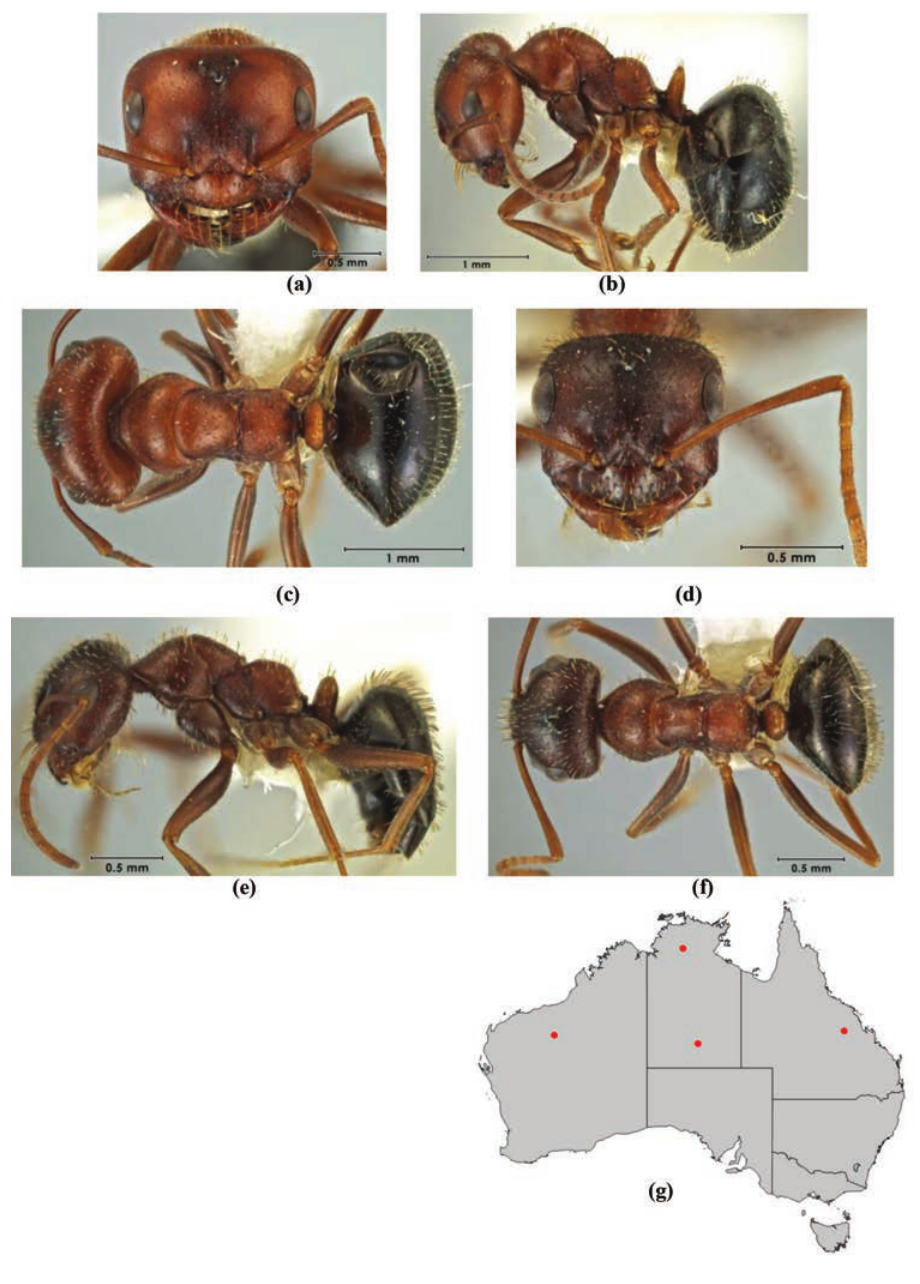
Figure 70. Melophorus setosus sp. n.: major worker paratype (ANIC32-066657–top ant) frons ( a ), pro- file ( b ) and dorsum ( c ); minor worker holotype (ANIC32-066657–middle ant) frons ( d ), profile ( e ) and dorsum ( f ); distribution map for the species ( g